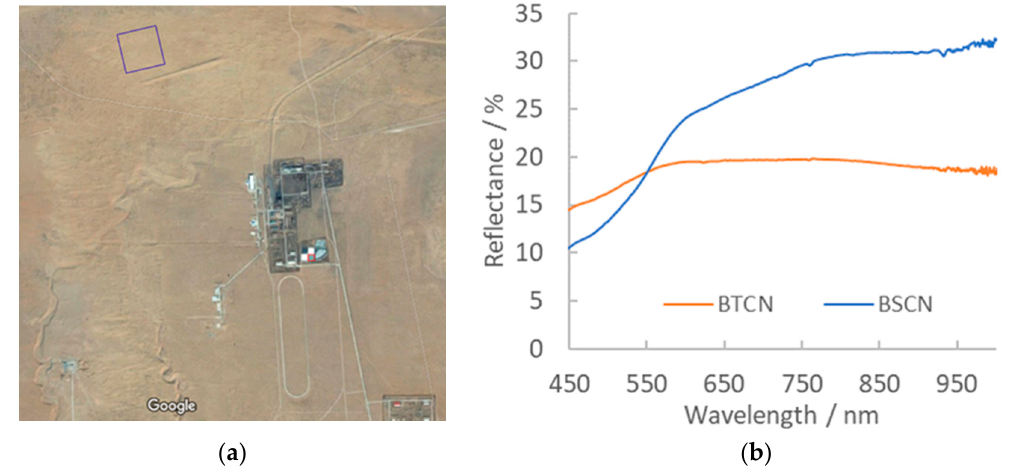
Figure 1. ( a ) The satellite image of the Baotou site; ( b ) the reflectance of BTCN and BSCN sites.